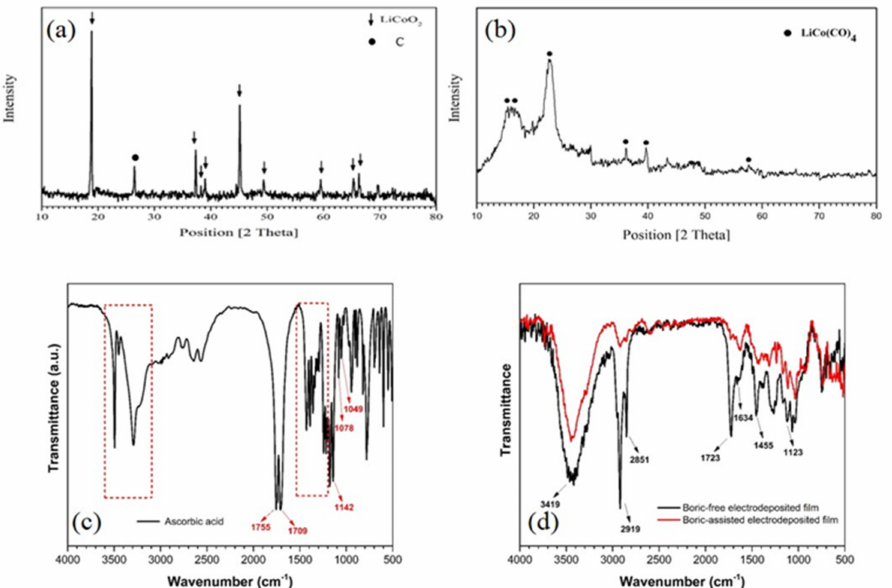
Figure 7. ( a ) XRD of the powder obtained from pretreatment of spent lithium-ion batteries (LIBs); ( b ) XRD of electrodeposited film onto plain carbon steel in optimum leaching bath of spent Li-ion batteries; ( c ) Fourier transformed infrared (FT-IR) spectra of ascorbic acid; and, ( d ) FT-IR spectra of electrodeposited coatings in presence and absence of 0.5 M boric